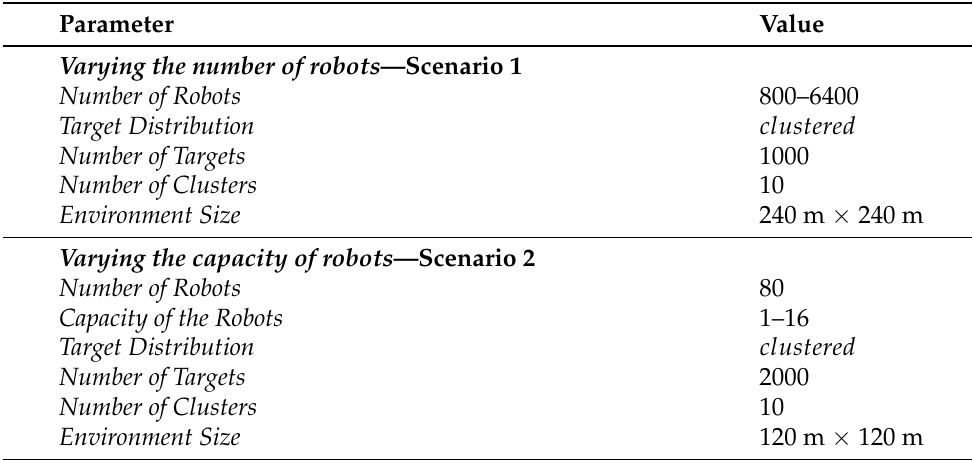
Table 6. Simulation scenarios parameters.